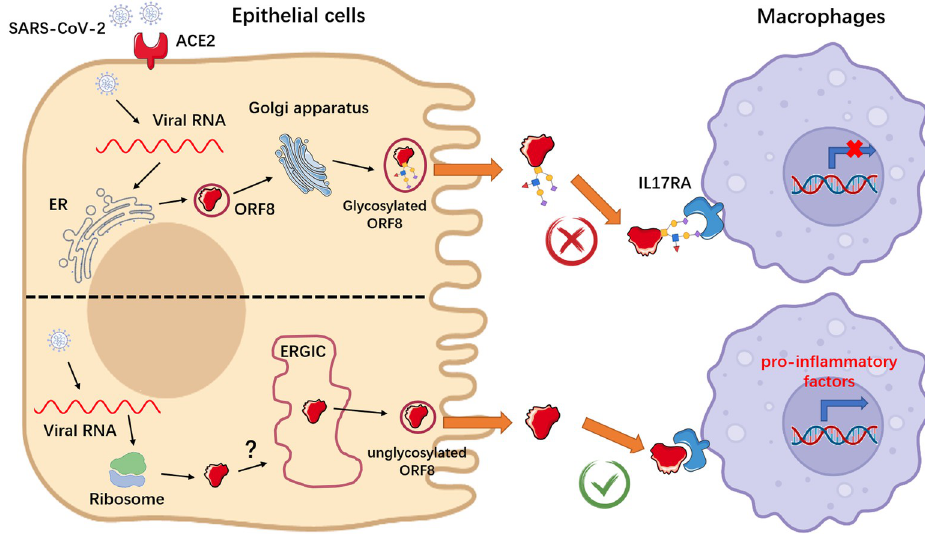
Fig 6. Schematic representation of conventional and unconventional secretion of ORF8 during SARS-CoV-2 infection.